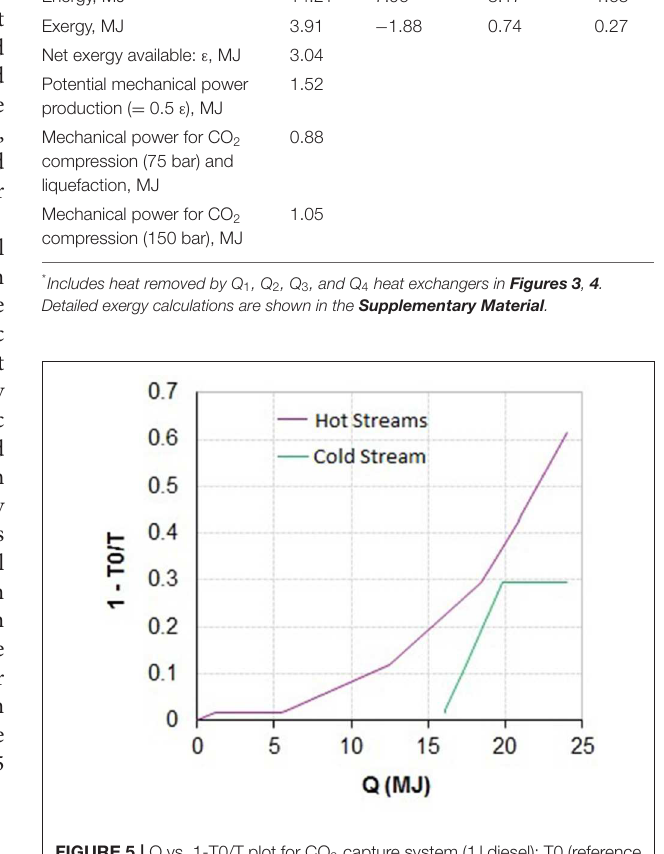
117.2 kg of CO 2 by consuming 50 l diesel, and 105.5 kg of CO 2 (90% capture) should be captured and stored by the CO 2 capture system. The working capacity (or CO 2 loading) of the adsorbent material is 0.1 kg-CO 2 /kg-adsorbent (Verdegaal et al.,